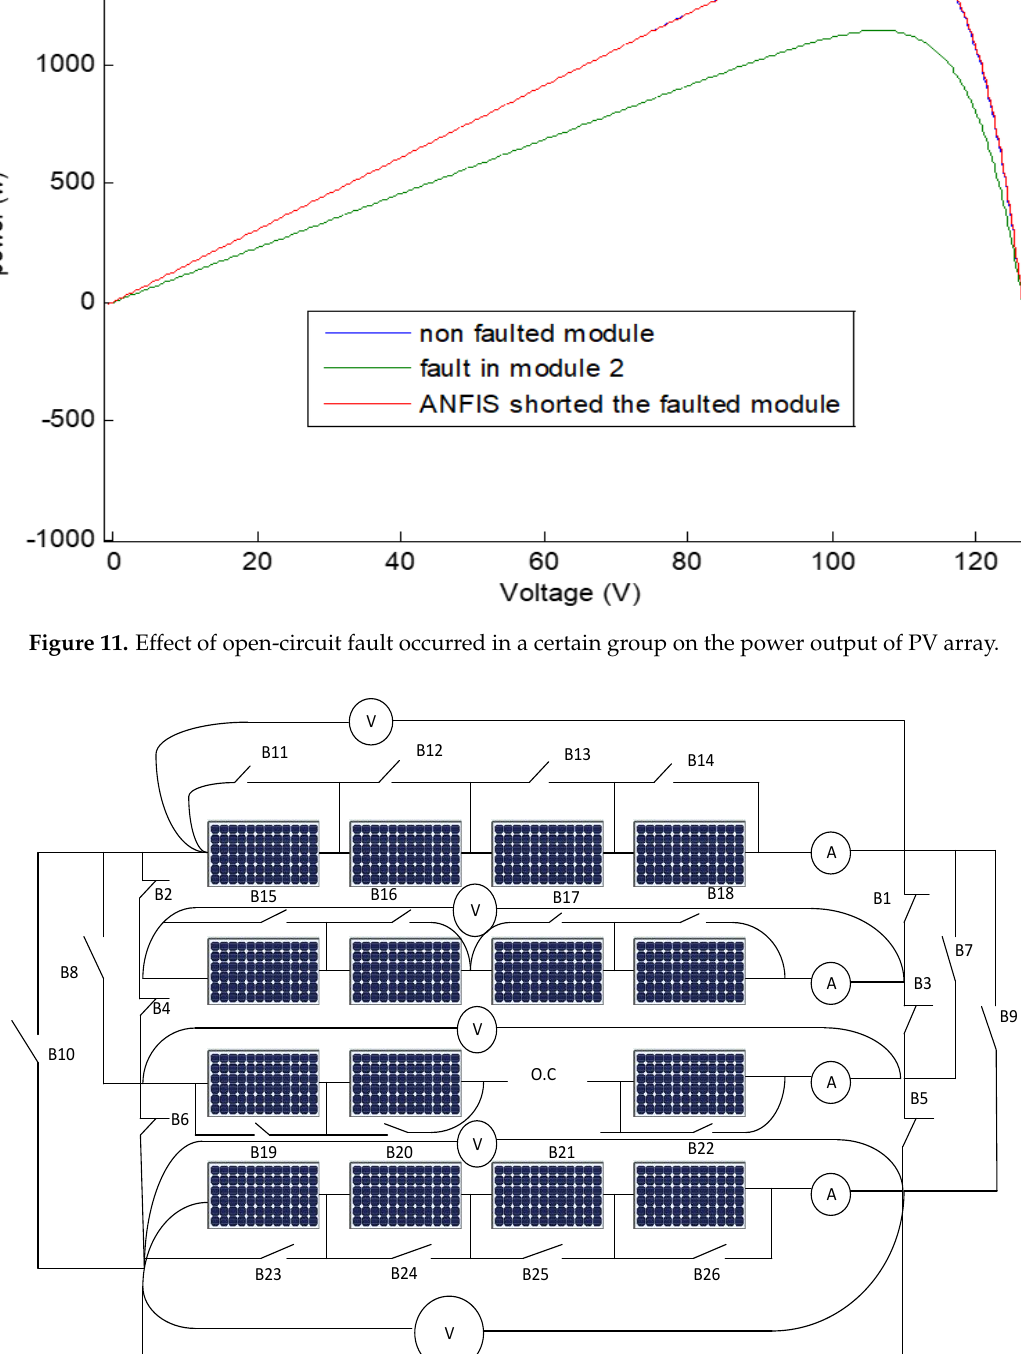
Figure 10. Effect of open-circuit fault occurred in a certain group on the power output of PV string.